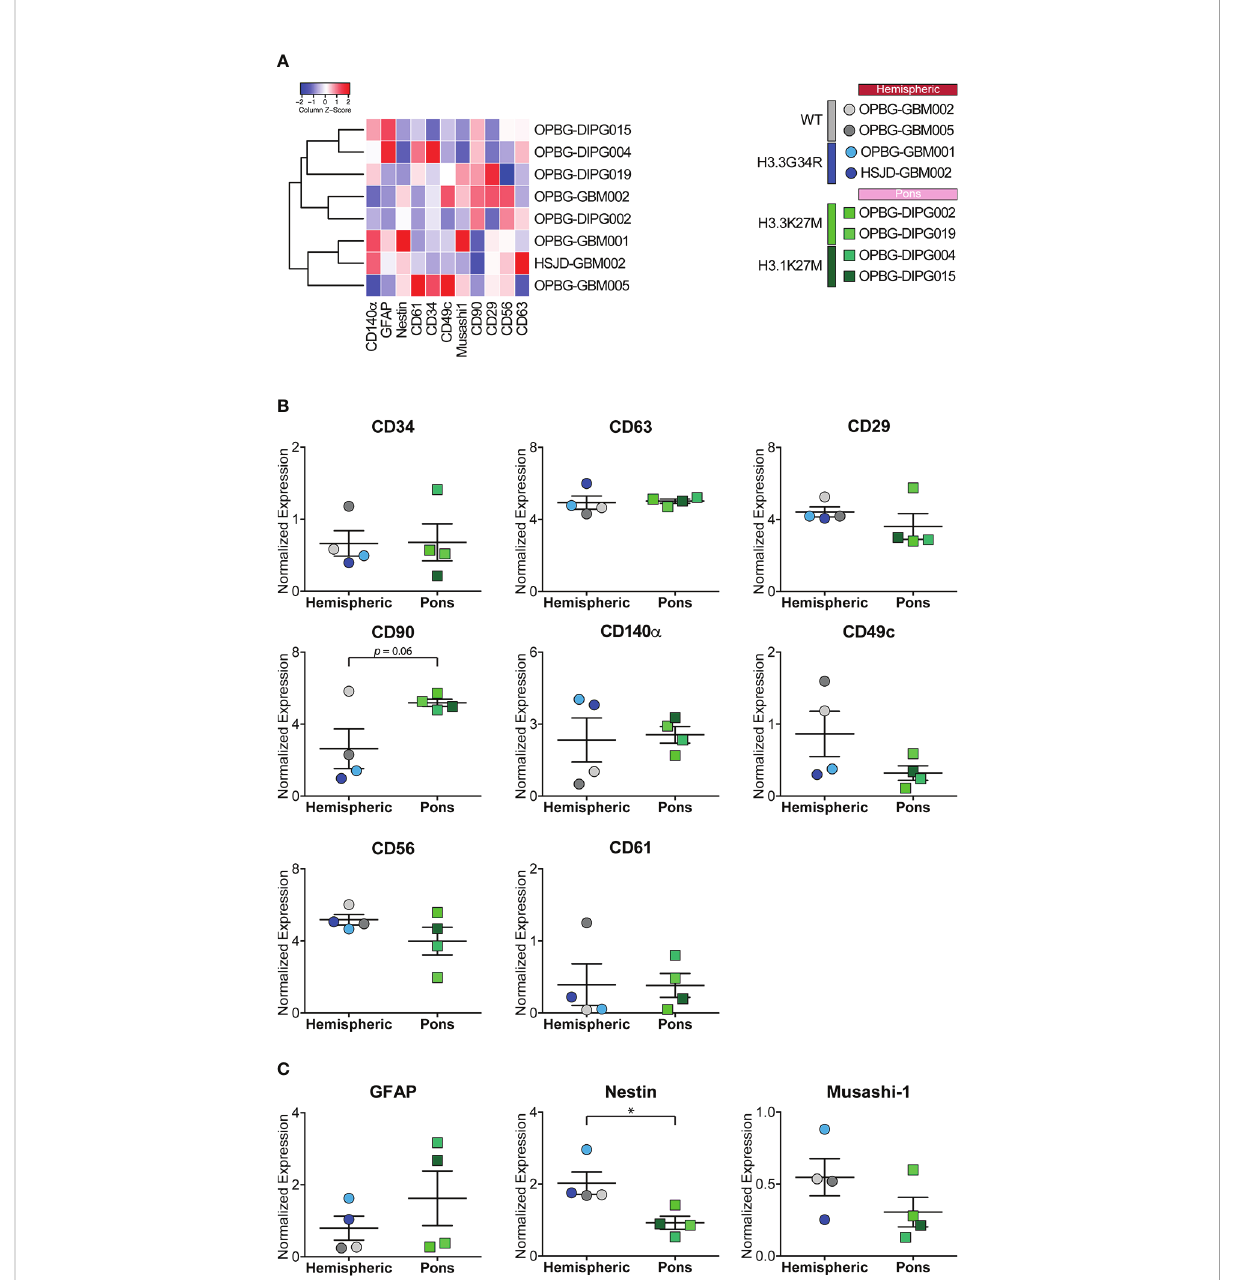
FIGURE 4 Marker expression analyzed through CyTOF technique in PDHGG patient-derived cell lines. (A) Heatmap summarizing the expression of the analyzed cell markers in the eight PDHGG cell lines. (B) Scatter dot plots showing the normalized expression of the indicated surface (B) and intracellular (C) markers in hemispheric and pontine PDHGG patient-derived cell lines. Each shape of the scatter dot plot indicates a different tumor location (round for hemispheric, square for pontine) while the color coding refers to the cell line mutational subgroups (see the key legend). * p <